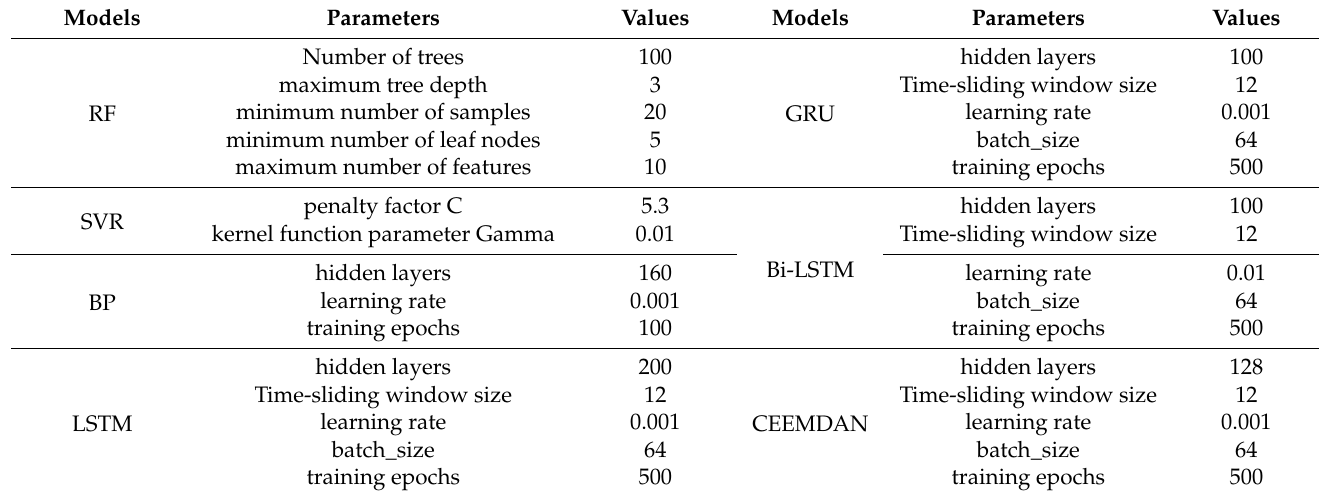
Table 2. Parameter settings of the different prediction models.